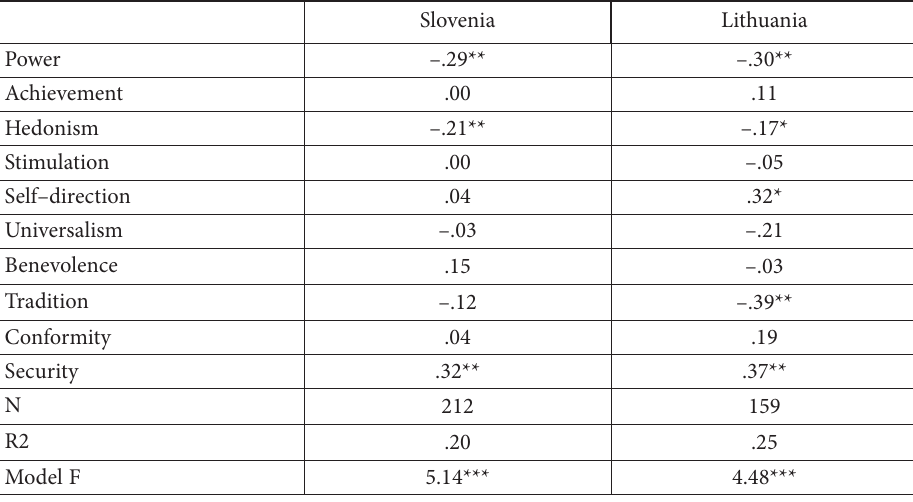
Table 7. Regression analysis results for the impact of personal values on destructive behavior (created by the authors)